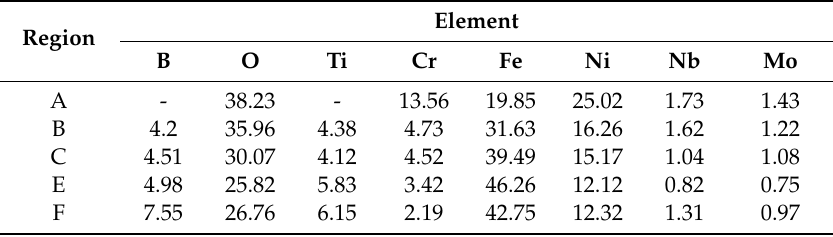
Table 6. Chemical composition of materials in di ff erent regions (wt.%). Element Region B O Ti